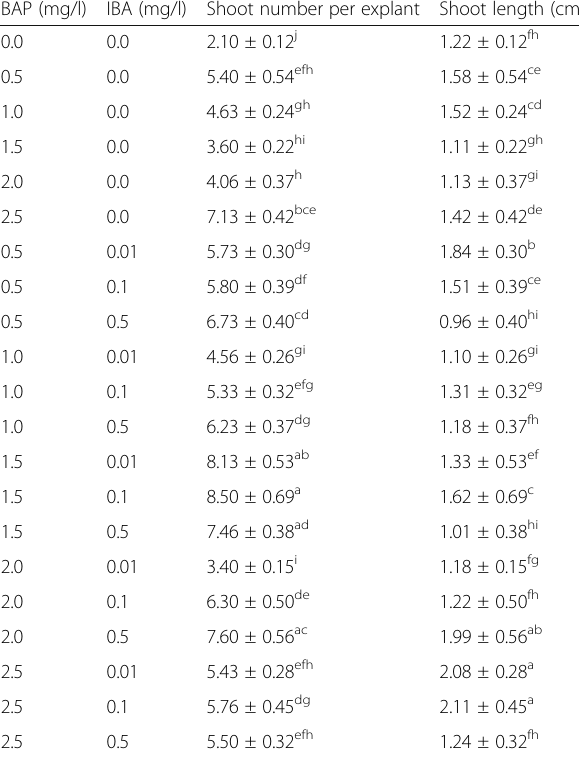
Table 4 Effect of different concentrations of BAP and IBA on shoot multiplication (shoot number and length) of